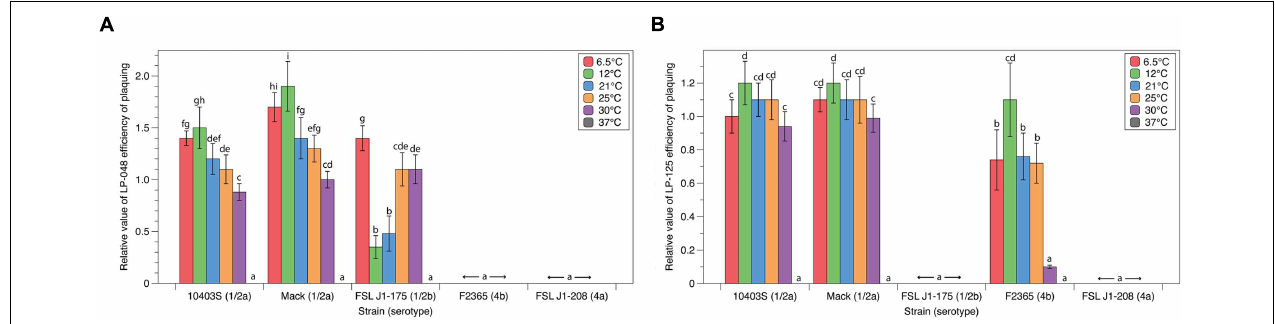
FIGURE 2 | Plaquing efficiencies of P100-like phages at varying growth temperatures. The relative number of visible plaques under different strain and temperature conditions were compared for phages (A) LP-048 and (B) LP-125. All values are relative to the phages isolation conditions (strain Mack at 30 ◦ C). Bars that do not share any letters represent values that are significantly different; for example, a bar marked with d, e, and f is significantly different from a bar marked with g and h. Three biological replicates were conducted. Error bars represent the standard